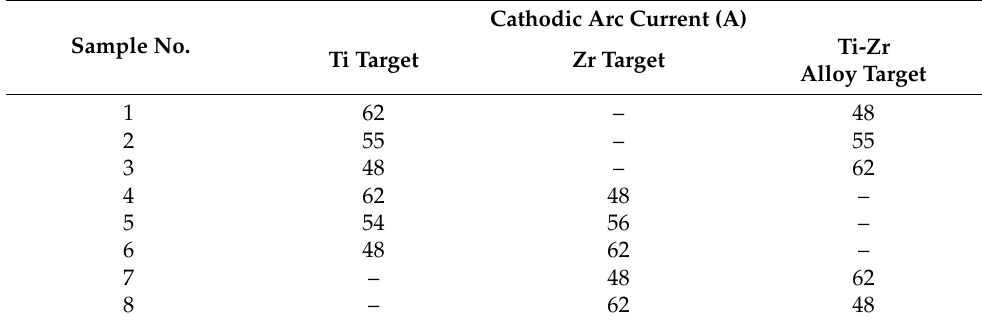
Table 1. Cathodic arc current combination during the deposition of Ti x Zr 1 − x N films (total current = 110 A).